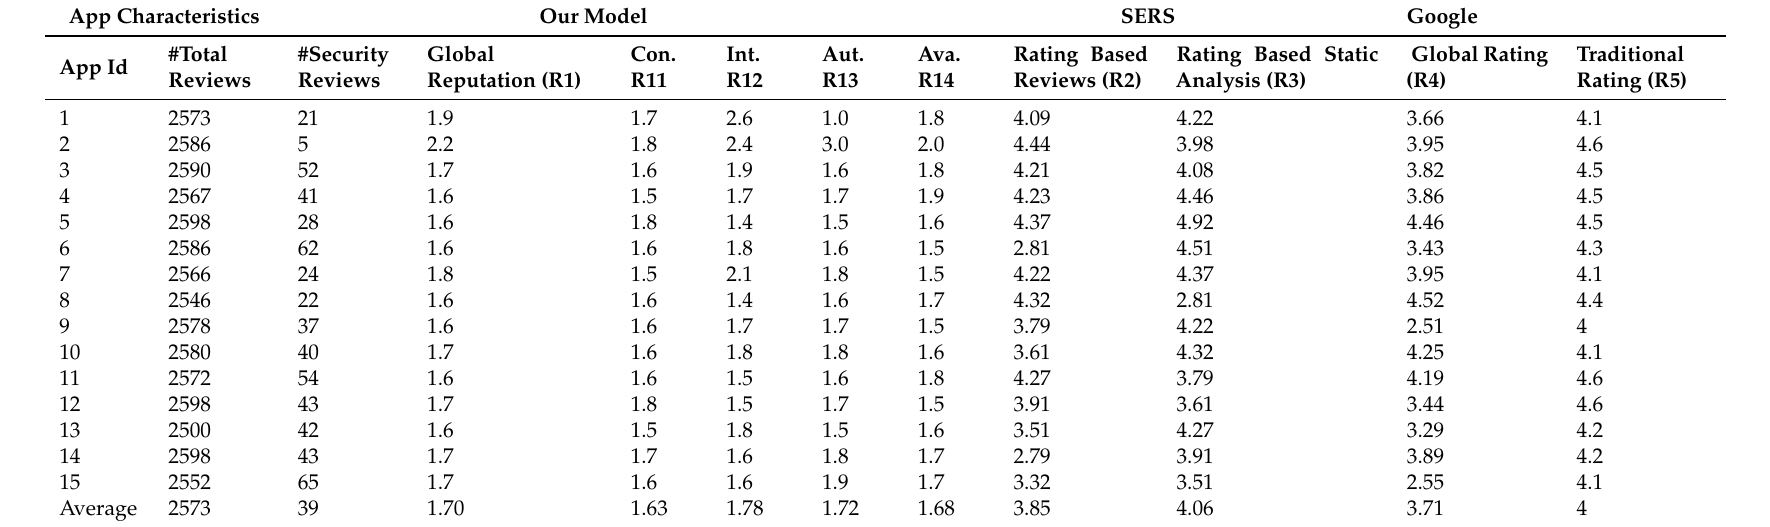
Table 7. Results about reputation and rating without